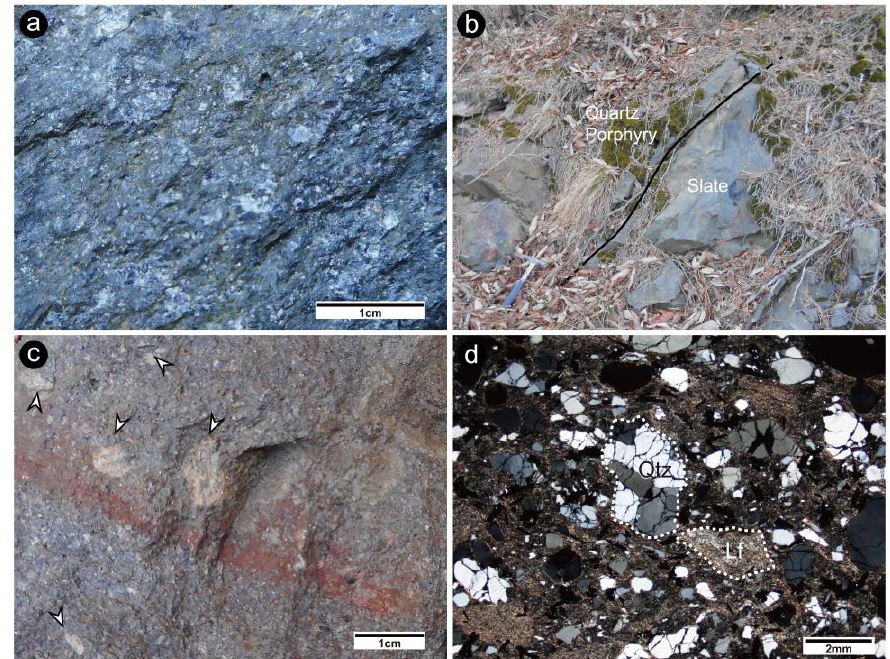
Figure 4. Photographs showing volcanic rocks in the Deokjeok Formation in the hanging wall of the Buk-ri Thrust. ( a ) Outcrop photograph of quartz porphyry. ( b ) Outcrop photograph showing the concordant relationship between the quartz porphyry and sedimentary layers. ( c ) Outcrop photograph of a felsic tuff, including sub-rounded to sub-angular, various sized lithic fragments (white arrow). ( d ) Photomicrograph (cross-polarized light) of a felsic tuff showing fractured quartz crystals and lithic fragments in the sericite-bearing finer matrix. Abbreviations: Qtz—Quartz, Lf—Lithic fragment.